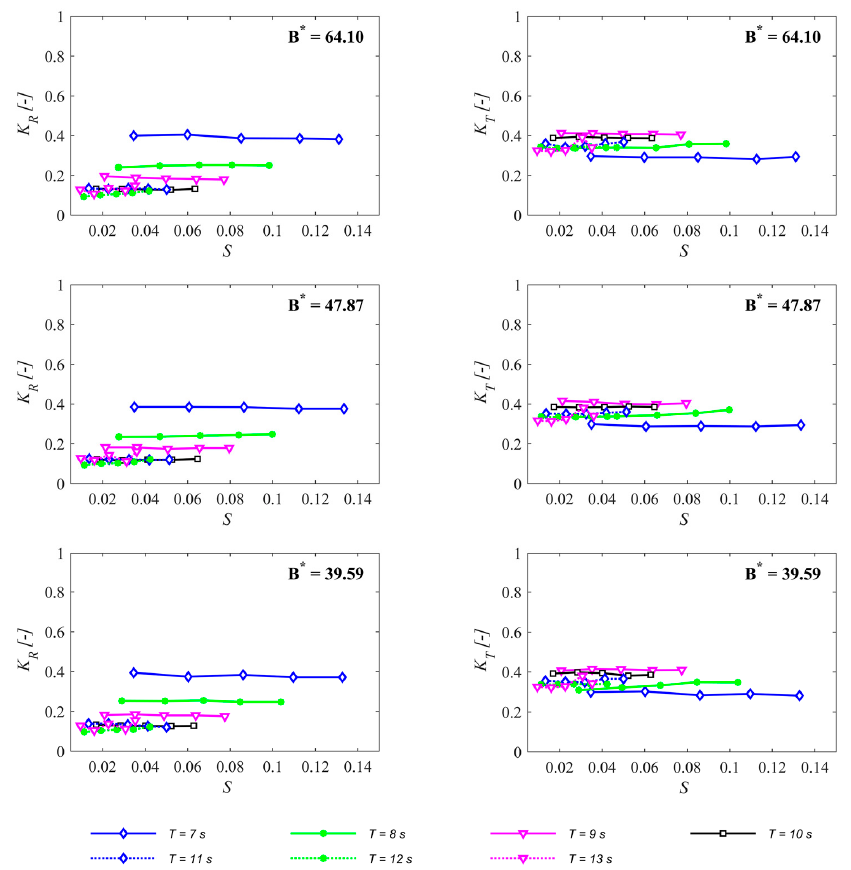
Figure 6. Variation of the reflection and transmission coefficients ( K R and K T ) with the wave steepness ( S ) for regular waves (Series A); and for different values of the wave period ( T ) and damping coefficient ( B * ) (prototype data).